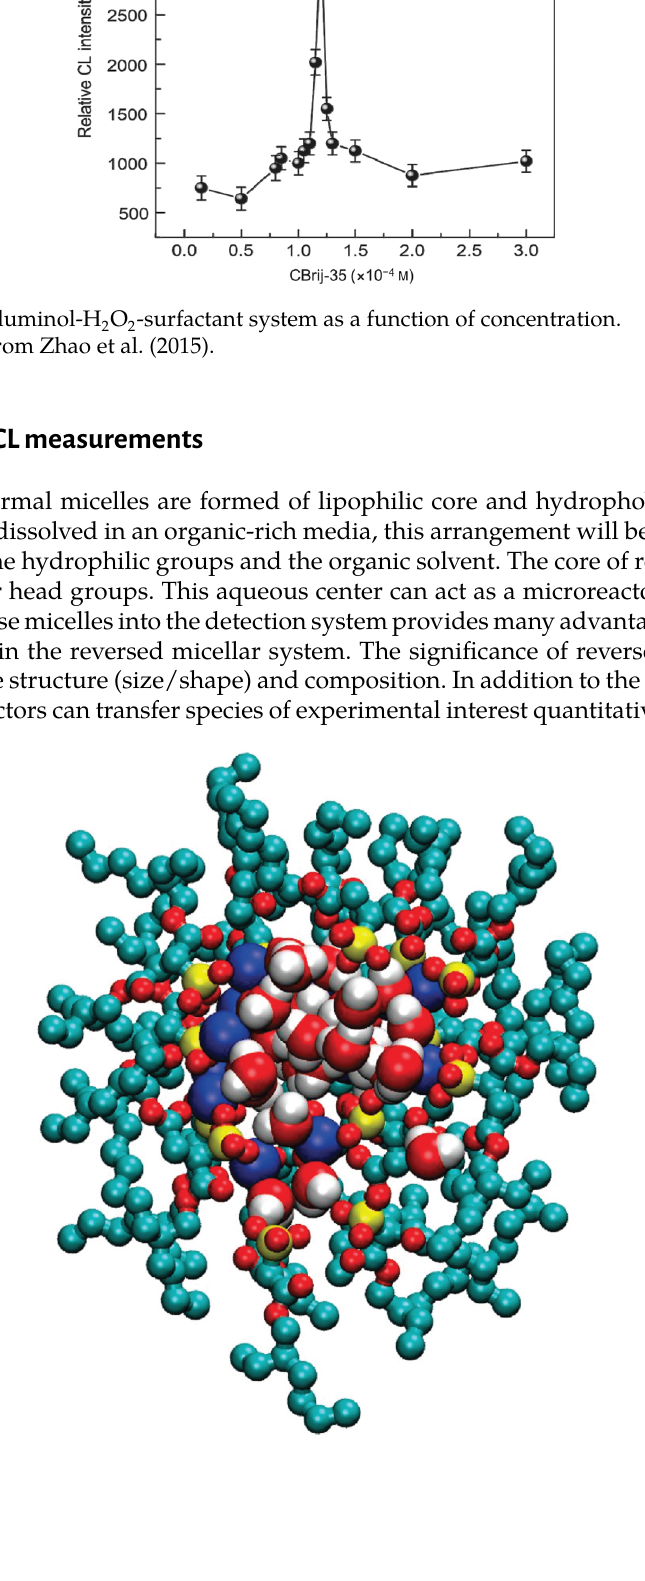
O -surfactant system as a function of concentration. 2 2